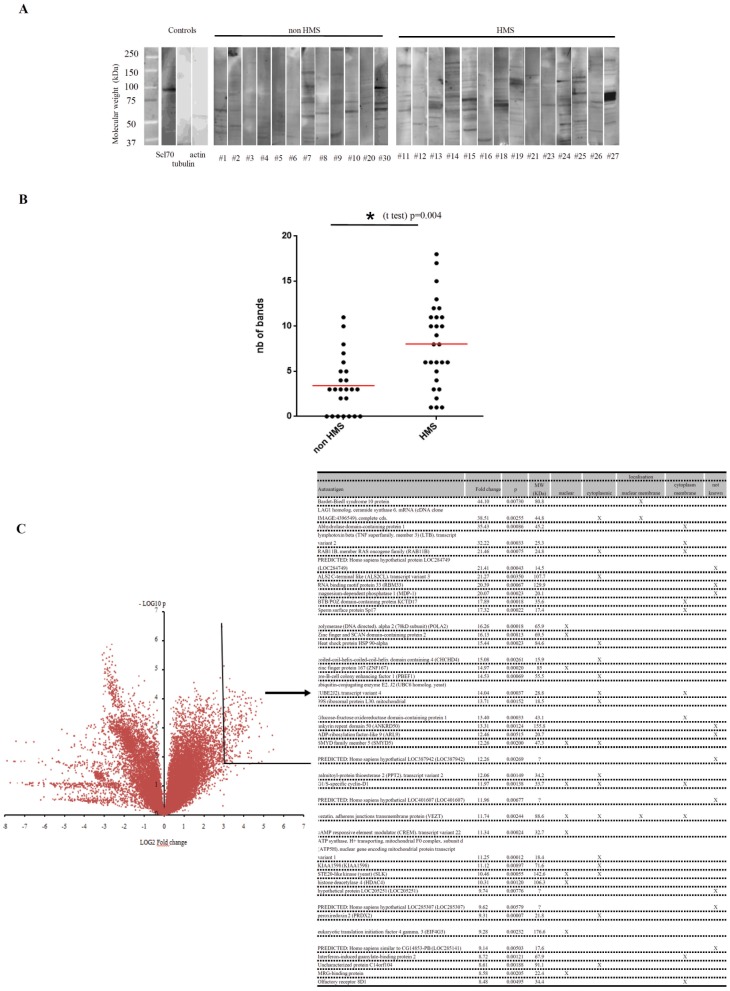
Polyclonal autoantibodies of IgG isotype are responsible for the malaria related pattern.
A Detection by Western blotting of autoantibodies in the serum of malaria patients recognizing HEp-2 cells proteins. Each lane corresponds to an individual experiment with the serum obtained from indicated patient. Positive control are shown with anti-actin and anti-tubulin monoclonal antibodies and anti-Scl70 positive serum obtained from a patient with systemic sclerosis. B Comparison of the number of bands observed on Western blotting gels in non-HMS (n = 12) and HMS (n = 14) malaria. Comparison made using a non-parametric U Mann-Whitney test. C Determination of the targets of malarial autoantibodies. Targets of the IgGs isolated from three patients with HMS and from pooled sera of five patients with acute malaria were compared with the targets of IgGs from five healthy donors using a protein array (four experiments for malaria and five for healthy donors). Each of the 9 400 protein targets were plotted on a volcano plot. Targets with a fold change superior to eight with a statistical significance inferior to 0.01 that we considered as highly specific for malaria are shown in the chart. For each target, the cellular localization of the protein is indicated.